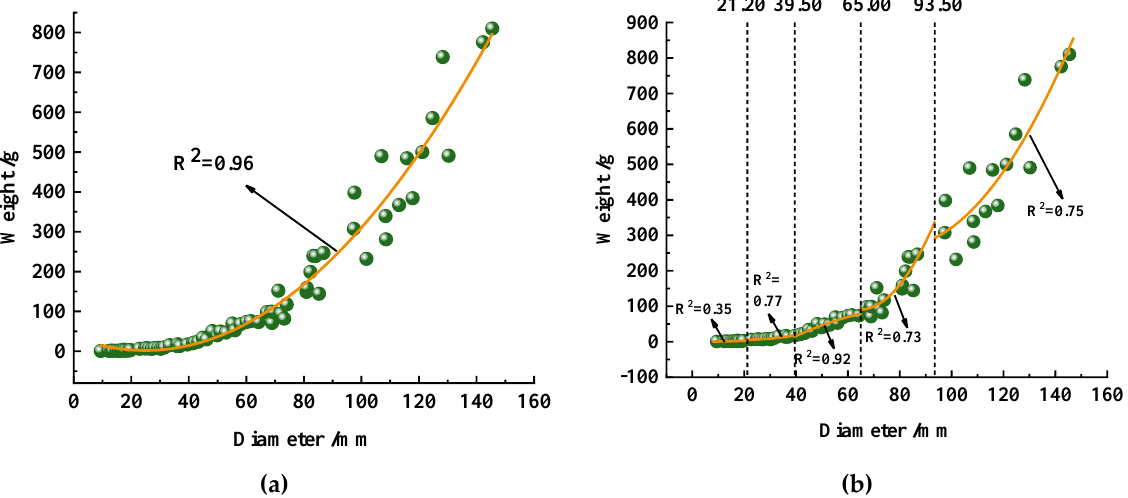
Figure 14. Fitted results. ( a ) All blocks are fitted with a curve. ( b ) Soil blocks of different classes are fitted by a single curve.